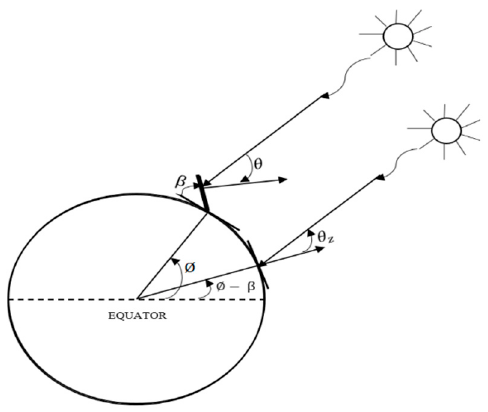
Figure 4. Diagram of the equality of angles θ and θ z , adapted with permission from Liu and Jordan